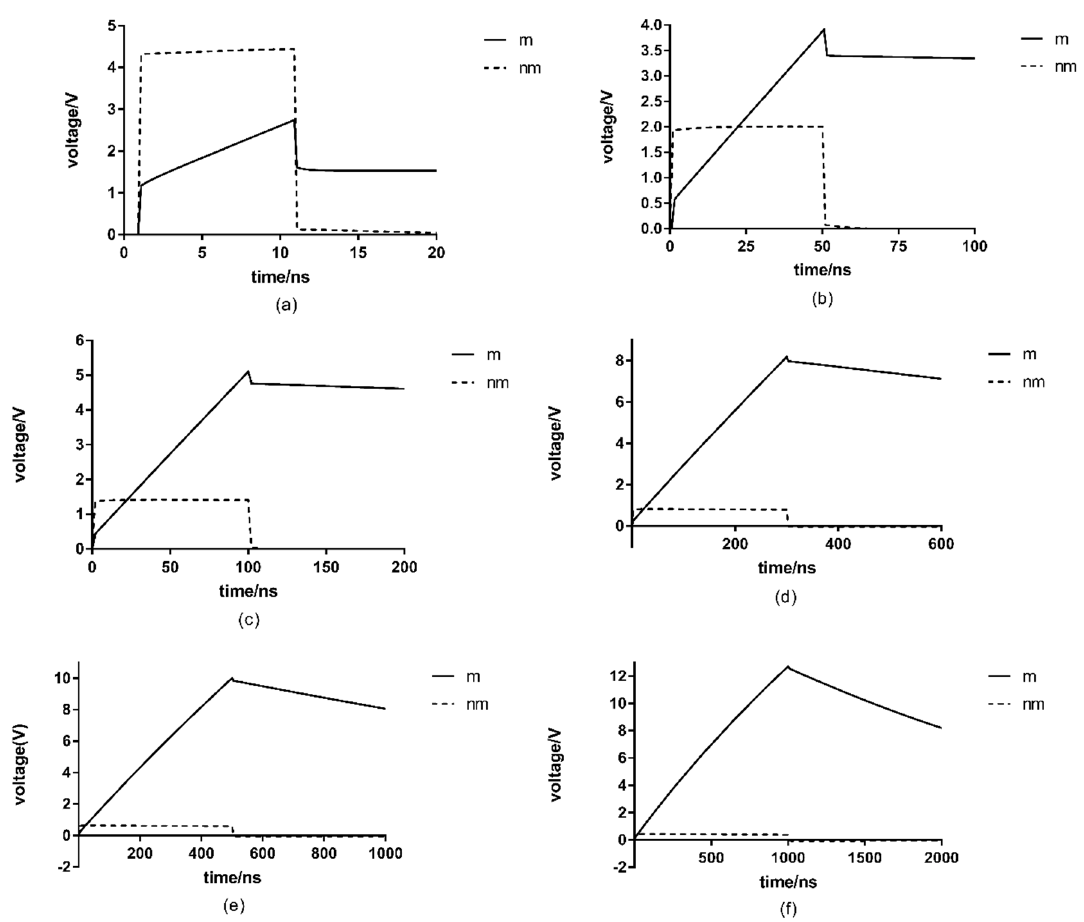
Figure 2. Results from analysis of effects from pulsed electric field on cell membranes and nuclear membranes, for six conditions: ( a ) 130 kV/cm and 10 ns; ( b ) 58 kV/cm and is 50 ns; ( c ) 41 kV/cm and 100 ns; ( d ) 23.8 kV/cm and 300 ns; ( e ) 18.4 kV/cm and 500 ns; ( f ) 13 kV/cm and 1000 ns; m stands for the cell membrane transmembrane voltage and nm stands for nuclear membrane transmembrane voltage.